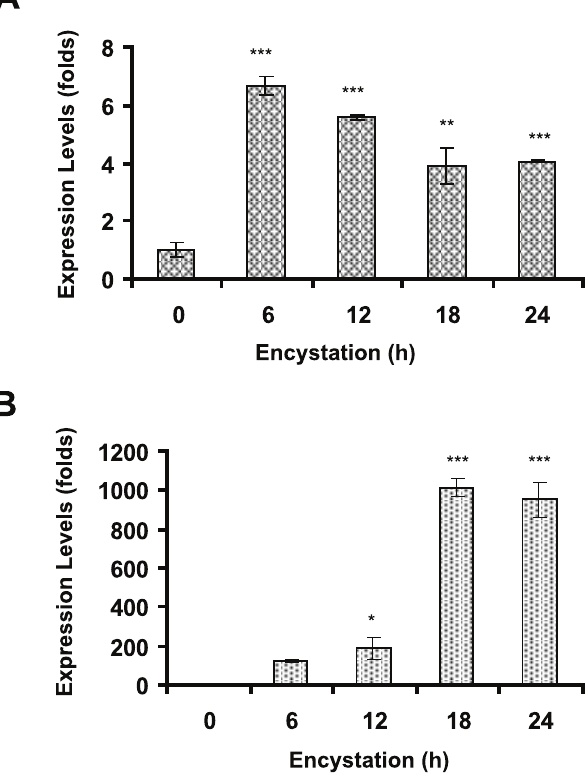
Figure 4. Relative-quantitative RT-PCR assay for rab11 and cwp1 during Giardialamblia encystation. Total RNA was obtained from parasites at different times during encystation (0, 6, 12, 18 and 24 h), and rab11 , p =0.0001 ( A ) or cwp1 , p , 0.0001 ( B ) expression was analyzed by relative-quantitative RT-PCR analysis.